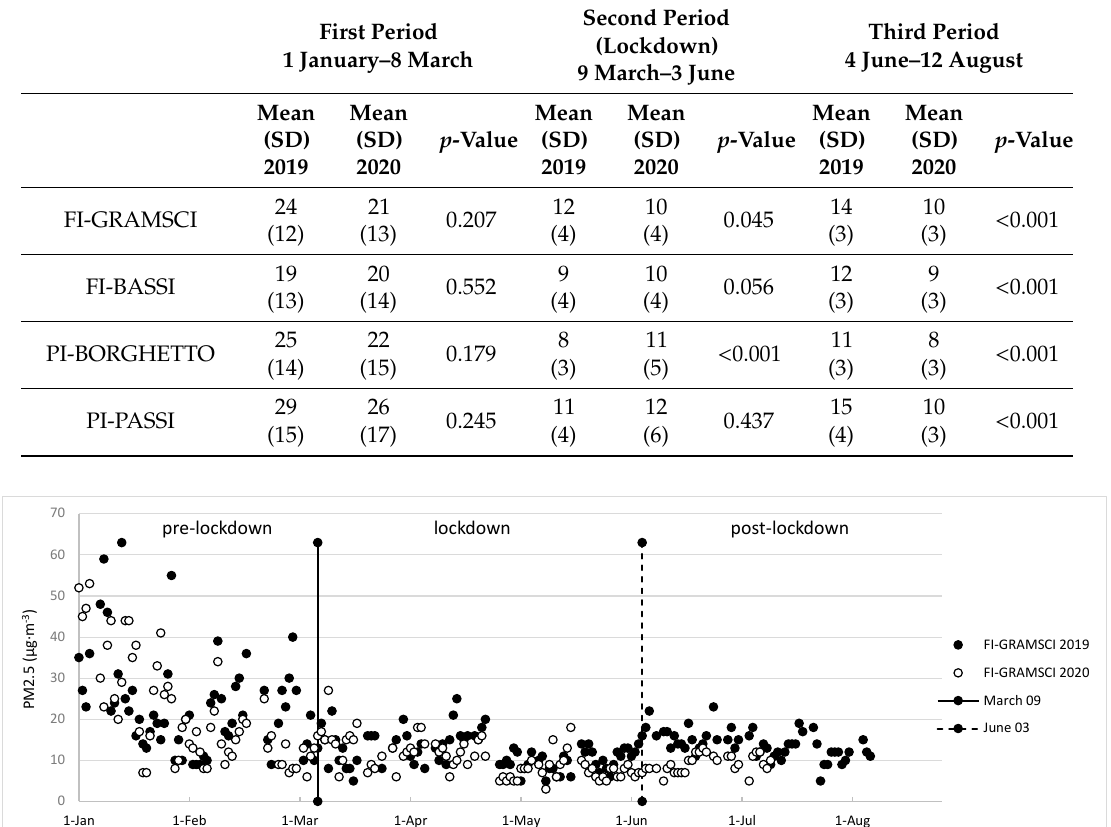
Figure 2. The daily mean concentration of PM2.5 ( µ g · m − 3 ). In each graph, the lockdown period is Figure 3. The daily mean concentration of PM2.5 ( μ g ∙ m − 3 ). In each graph, the lockdown period is depicted between the two vertical bars. depicted between the two vertical bars.